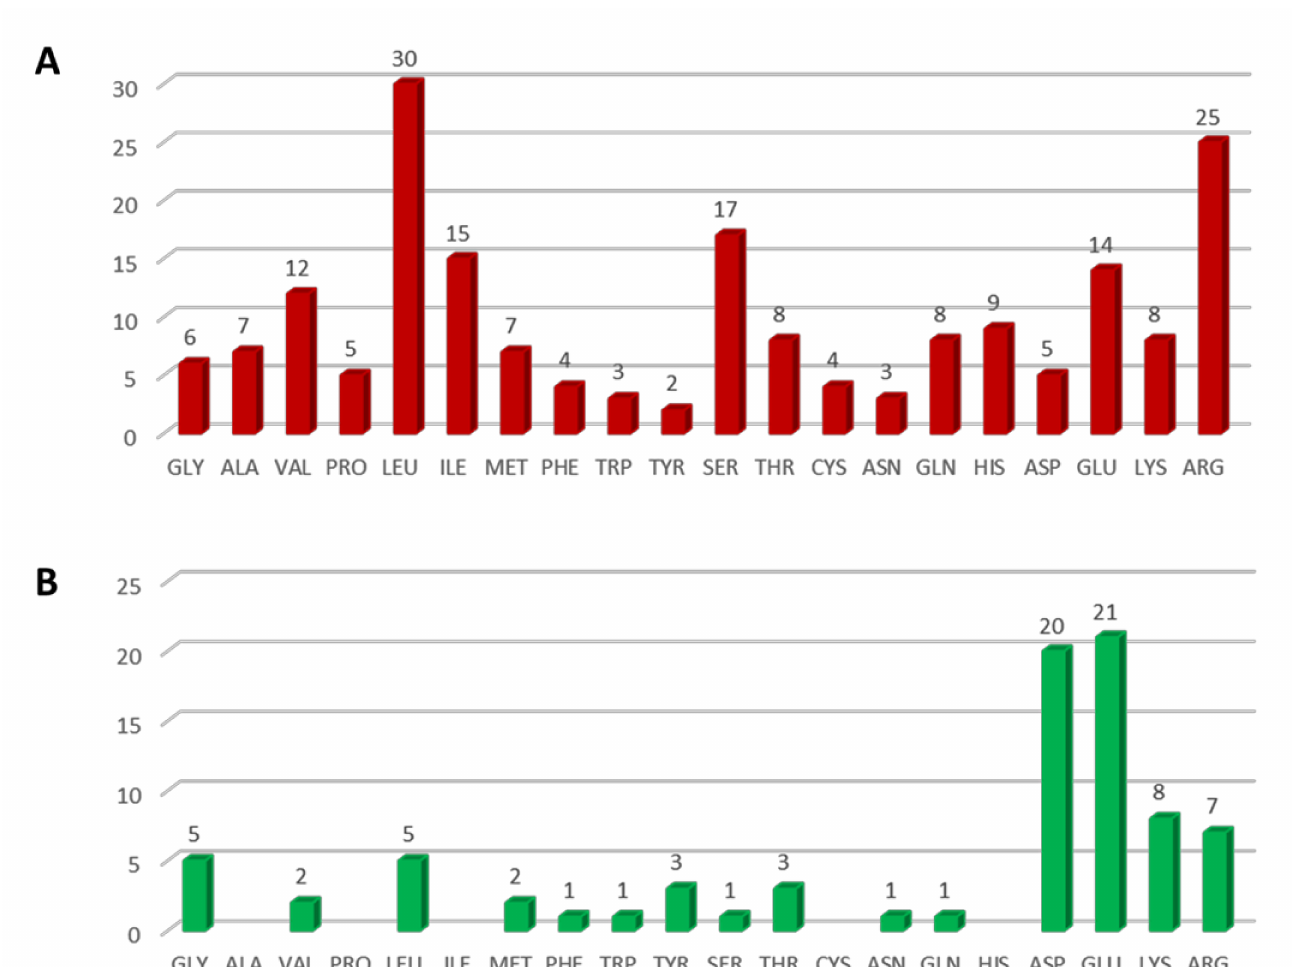
Figure 4. ( A ) Occurrence of surface residue types labeled as interacting by ISPRED4 [21]. The total number of residues predicted as interacting is 192 (Table S1). ( B ) Frequency of occurrence of surface residue types in the 3.5 Å-radius neighborhood of the 34 calcium-binding sites predicted with a 95% precision by FEATURE [22] (Table S1). Numbers over the columns indicate the absolute number, column labels follow the amino acids three letters